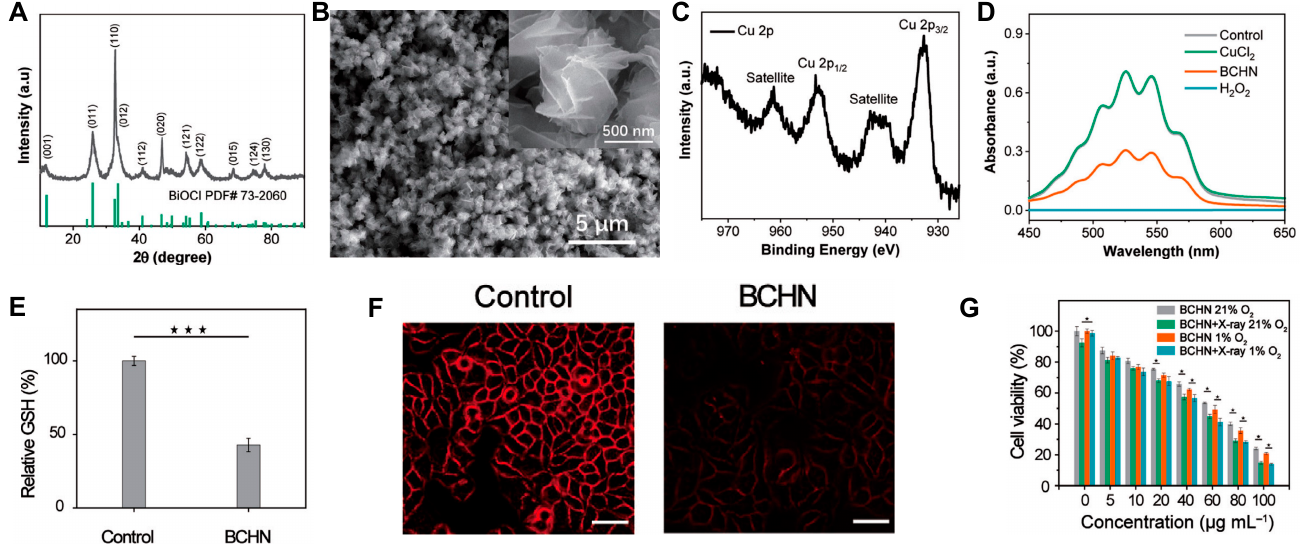
Figure 12. Hydrogen peroxide (H 2 O 2 )-loaded Cu-doped BiOCl nanocomposite (BCHN) to improve synergistic effect of radiation and chemodynamic therapy through modulating tumor microenvironment. ( A – C ) XRD pattern ( A ), SEM image ( B ), and XPS spectra ( C ) of BCHN. ( D ) UV–vis absorption spectra of KMnO 4 solution (50 µ g mL − 1 ) after adding CuCl 2 , BCHN, and H 2 O 2 , respectively (0.1 M H 2 SO 4 , reaction time = 10 min). ( E – F ) Relative GSH content ( E ) and oxygen levels ( F )in 4T1.2 cells without or with BCHN incubation. ( G ) Relative viability of 4T1.2 cells incubated with BCHN and further radiated with or without X-rays under normoxic and hypoxic conditions. Reproduced